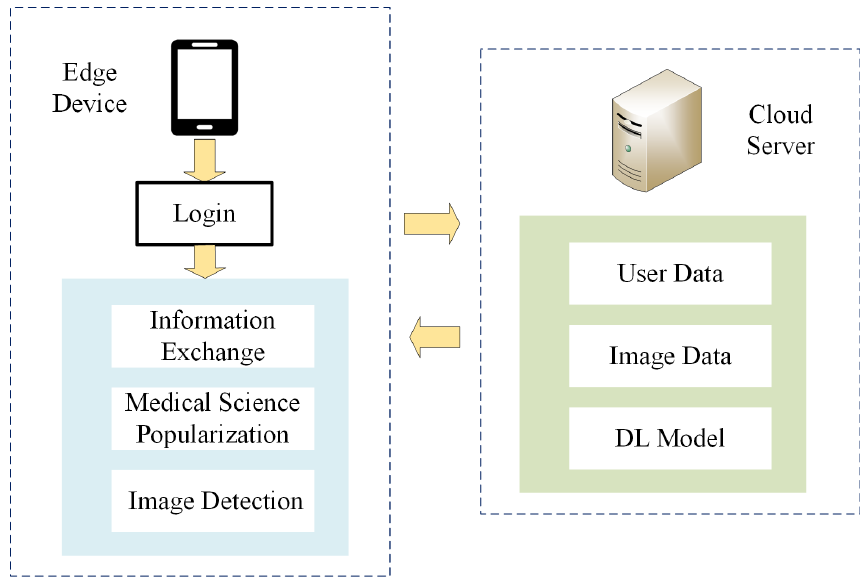
Figure 7. The execution flowchart of mobile